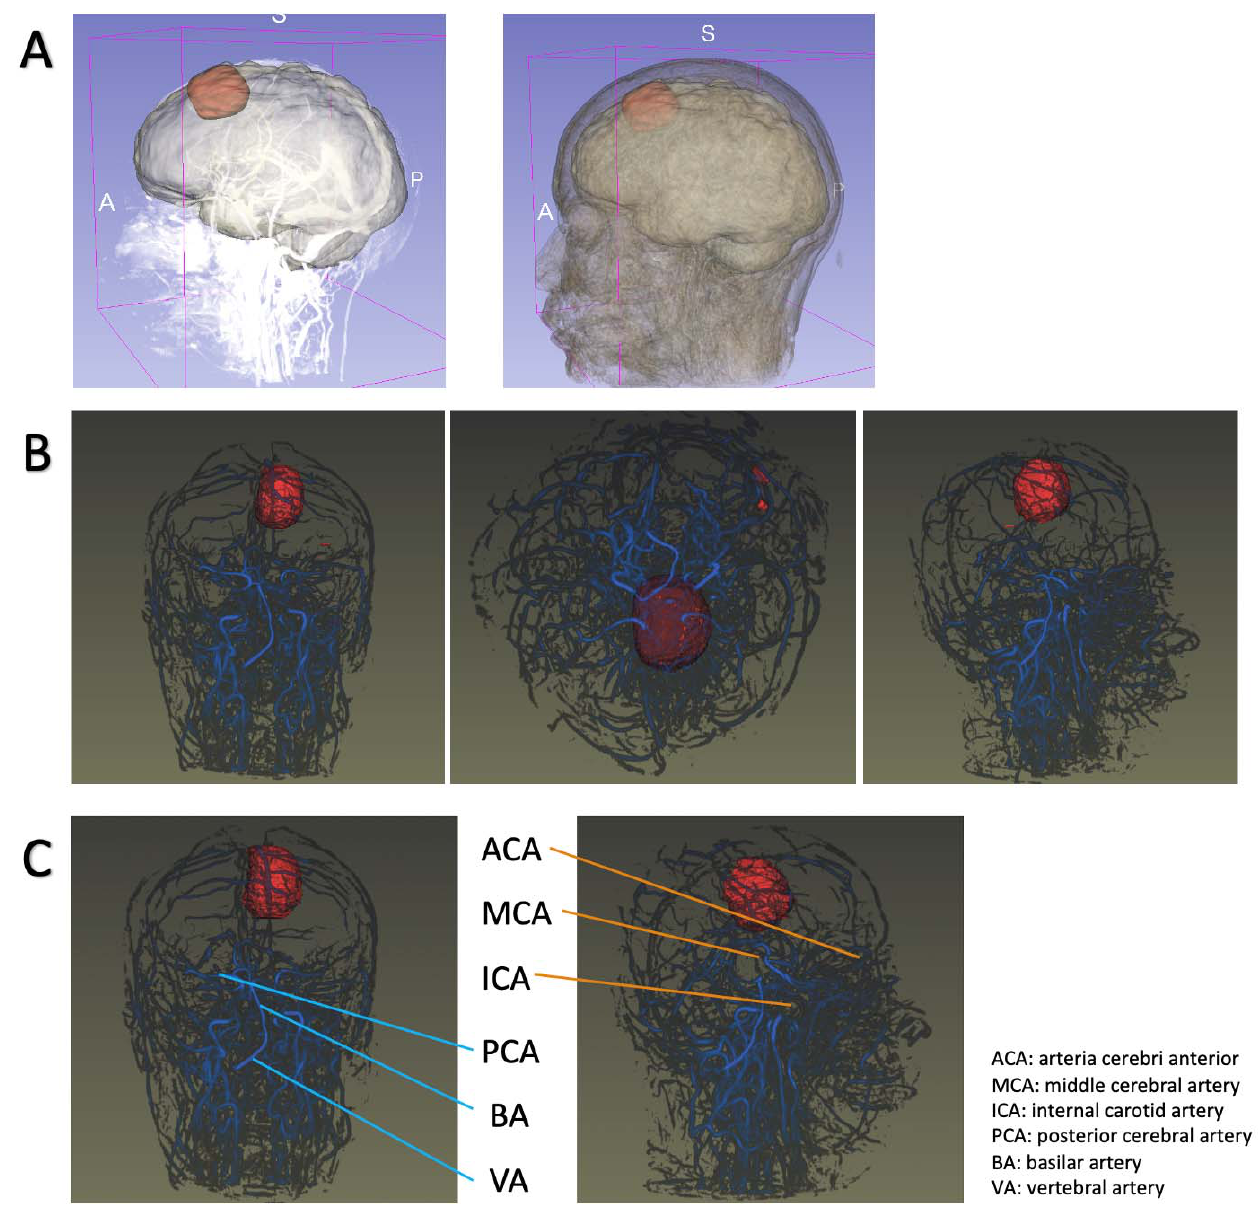
Figure 4. Intellectual system design. ( A ). meningioma demonstration system; ( B ). automatic renderings of tumors and intracranial vessels; ( C ). recognition of intracranial vessels.